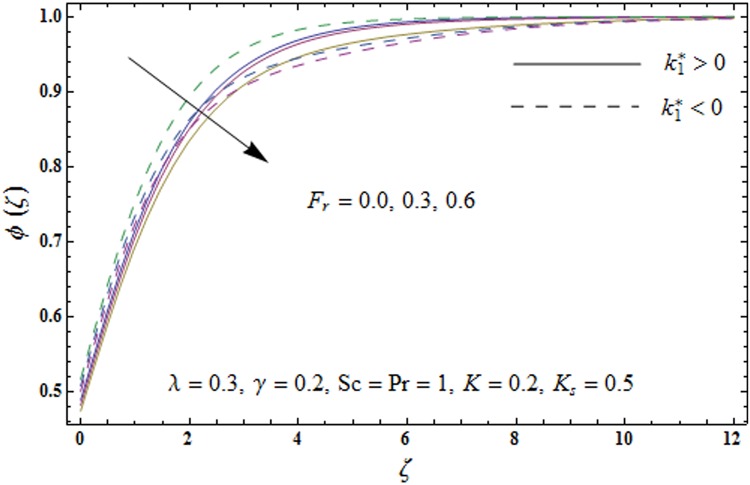
Plots of concentration field ϕ(ζ) for inertia coefficient Fr.